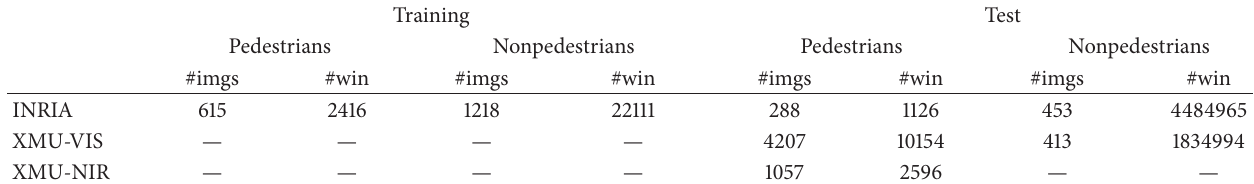
Table 1: INRIA training and test sets, XMU-VIS test sets, and XMU-NIR